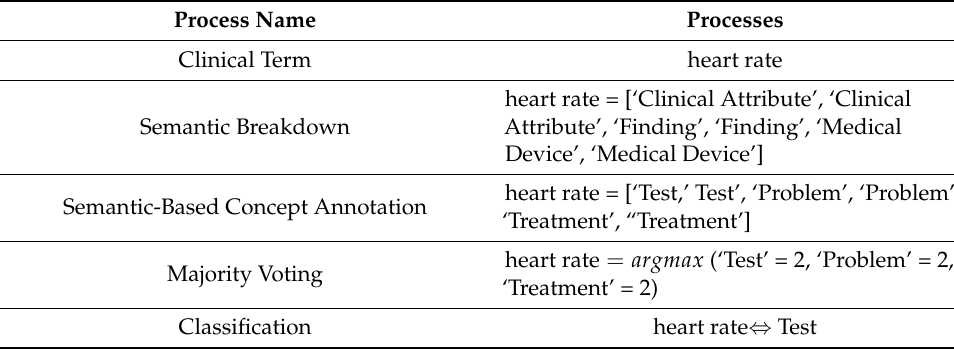
Table 3. The implementation scenario of Rule 2.